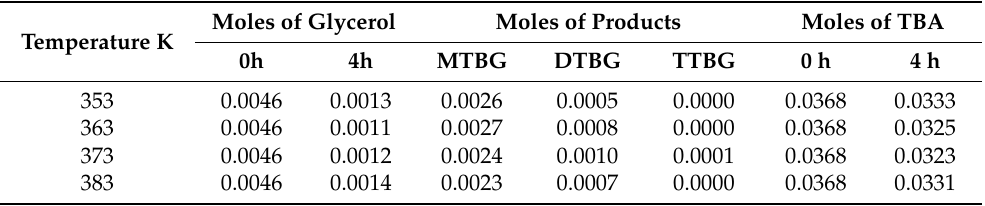
Table 10. Initial and final compositions at different temperatures. Moles of Temperature K